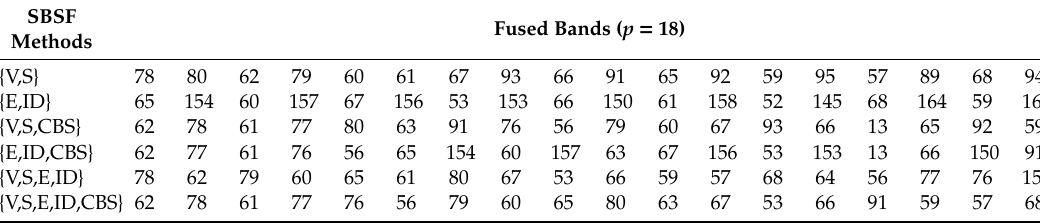
Table 2. The 18 bands selected by various simultaneous band selection fusion (SBSF) methods.